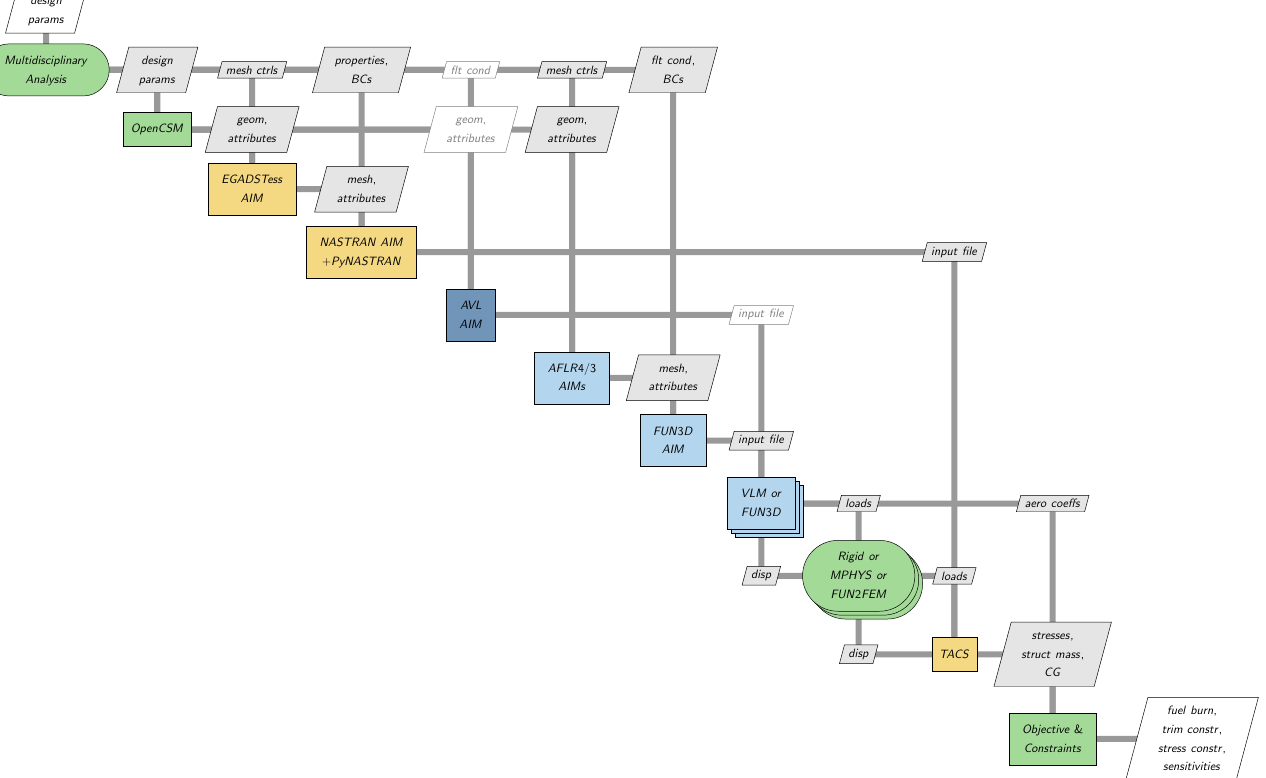
Figure 3. Extended Design Structure Matrix (XDSM) [25] depicting couplings of meshing and analysis for multi-fidelity, multidisciplinary analysis. Multidisciplinary elements are shown in green, structures in yellow, and aerodynamics in blue. Low-fidelity aerodynamics’ pre-processing is distinguished from high-fidelity using dark blue with faded inputs and